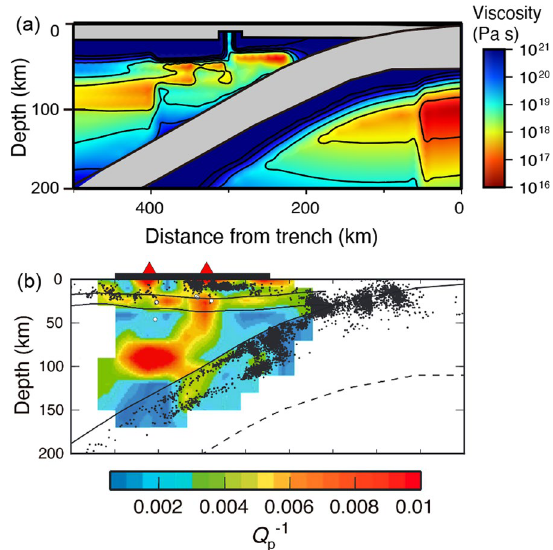
Fig. 11 a The heterogeneous rheology in the 2-D postseismic model of Muto et al. (2019). b The seismic P-wave attenuation profile across the Miyagi-Yamagata transect from Nakajima et al.